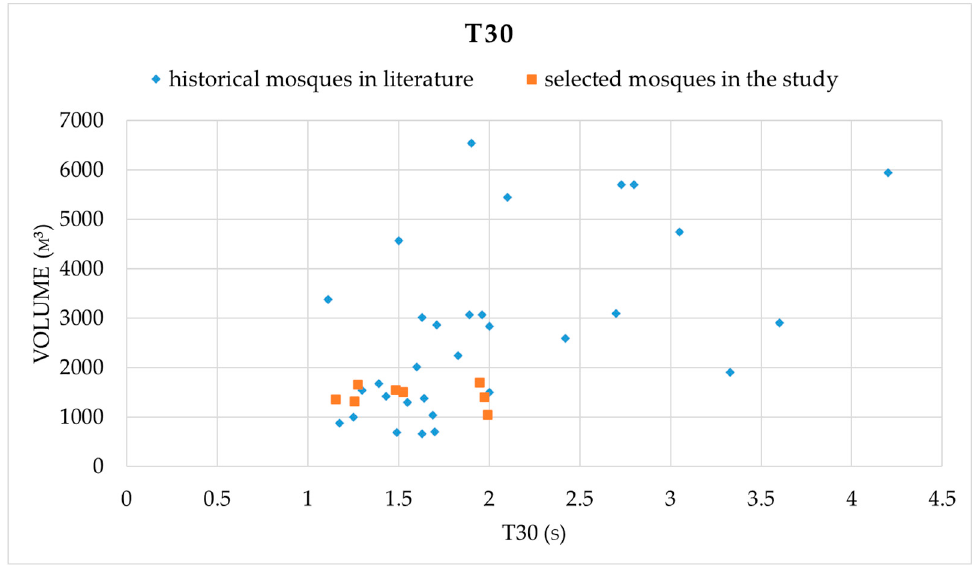
Figure 1. The T30 values of mosques in the literature and present